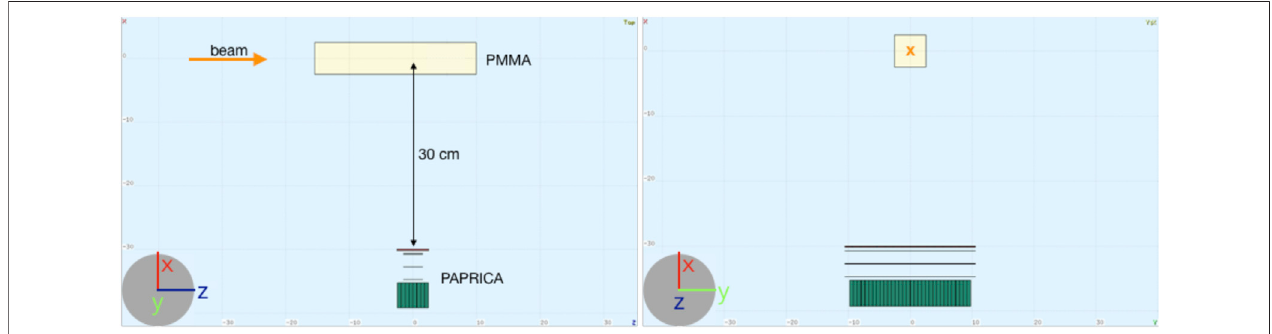
FIGURE 6 | Visualization of the FLUKA simulated geometry. The beam direction (in orange) is along the positive z -axis. Left: side view ( xz plane). Right: front view ( xy plane).